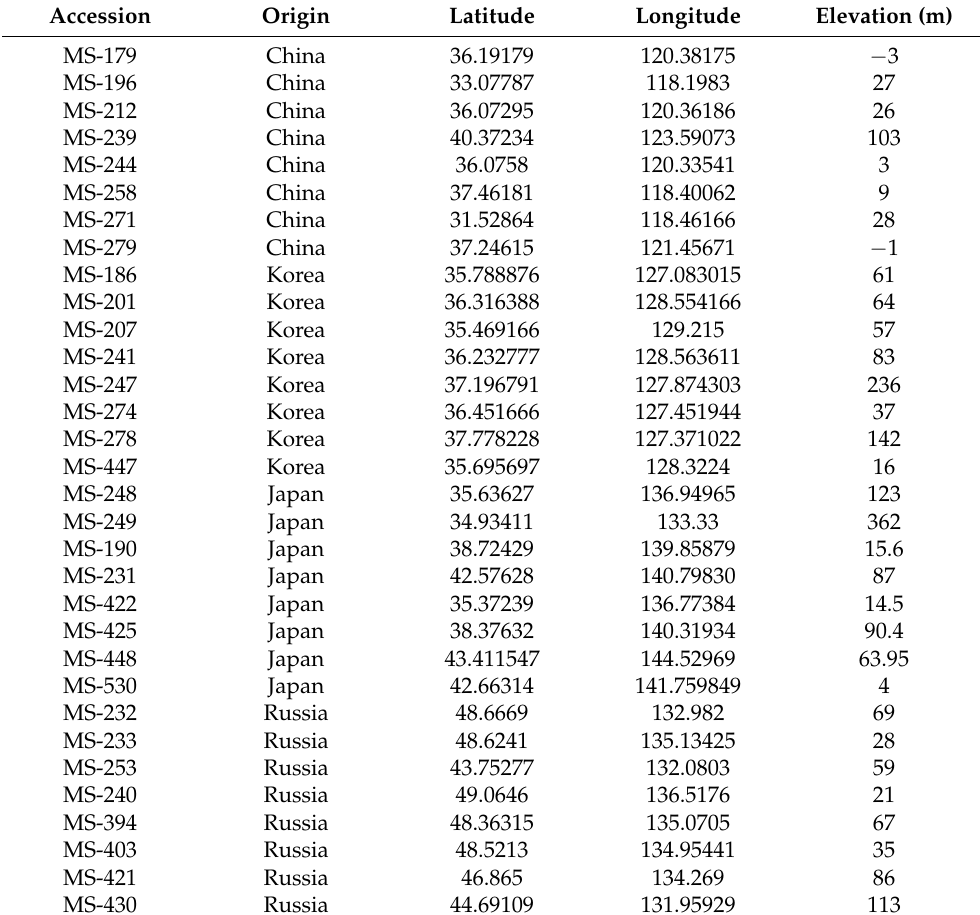
Table 1. List of M. sacchariflorus accessions, origin, altitude, latitude, and longitude used in the